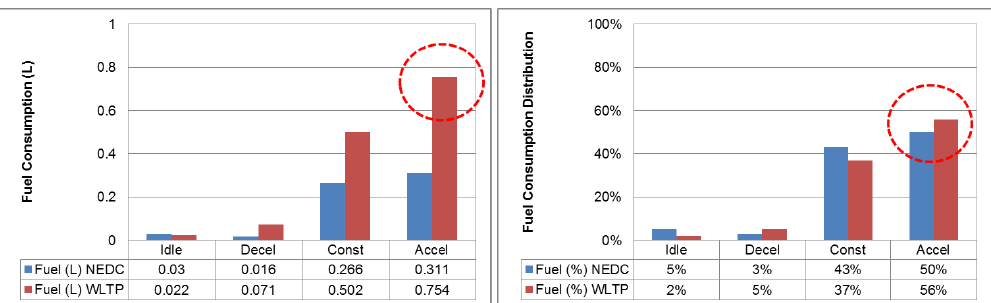
Figure 16. Contribution of the fuel consumption to the driving conditions (1.6 L diesel) .